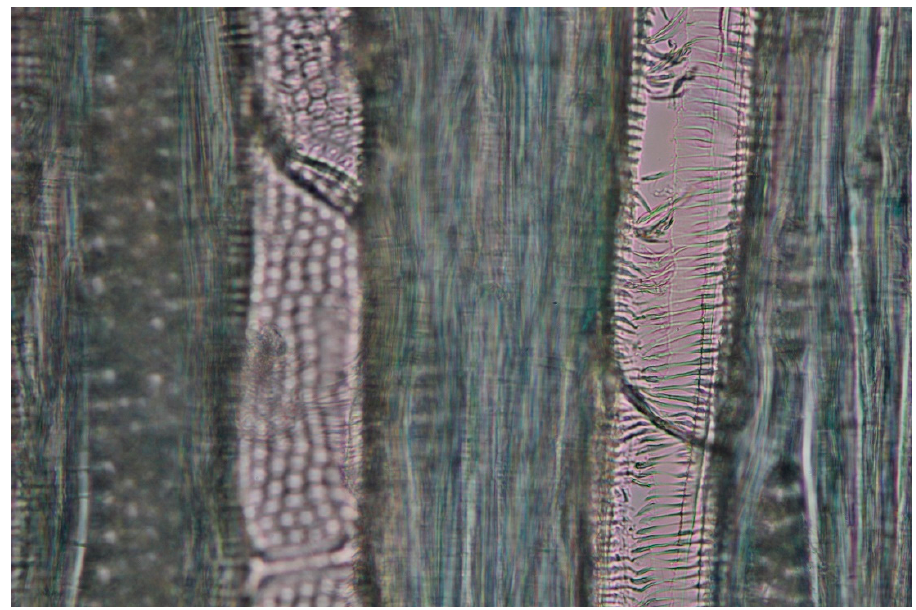
Figure 25. Tangential view of face veneer showing alternate intervessel pitting, spiral thickenings, and cross section of sample perforation plates (400×) that are characteristic of sugar maple (Acer saccharum).